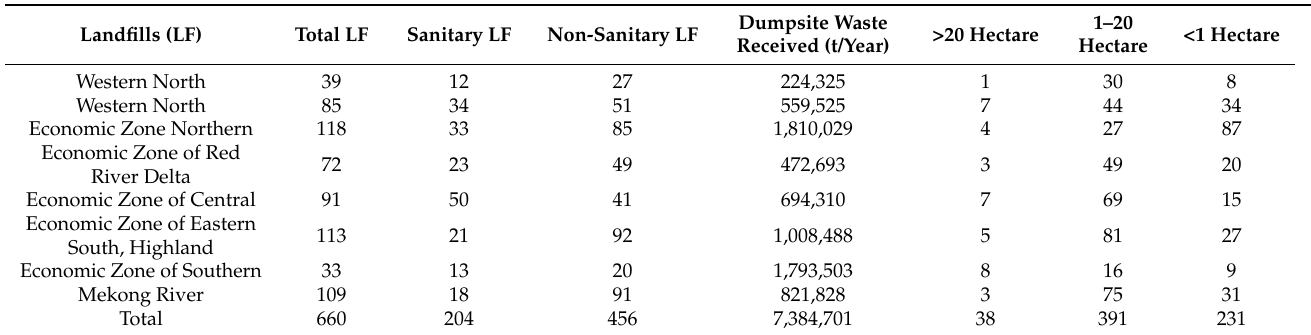
Table 1 elaborates the distribution of landfills and their capacity across Vietnam. Table 1. Distribution of landfills and their capacity in